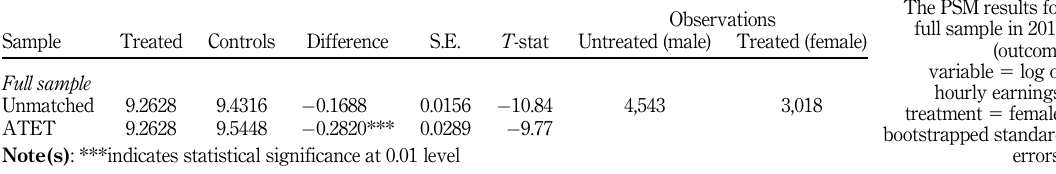
Table 3. The PSM results